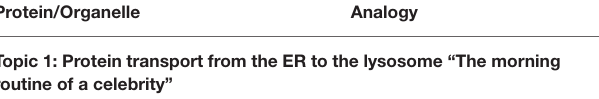
TABLE 3 | Examples of the analogies made in two of the role-plays. Protein/Organelle Analogy Topic 1: Protein transport from the ER to the lysosome “The morning routine of a celebrity”